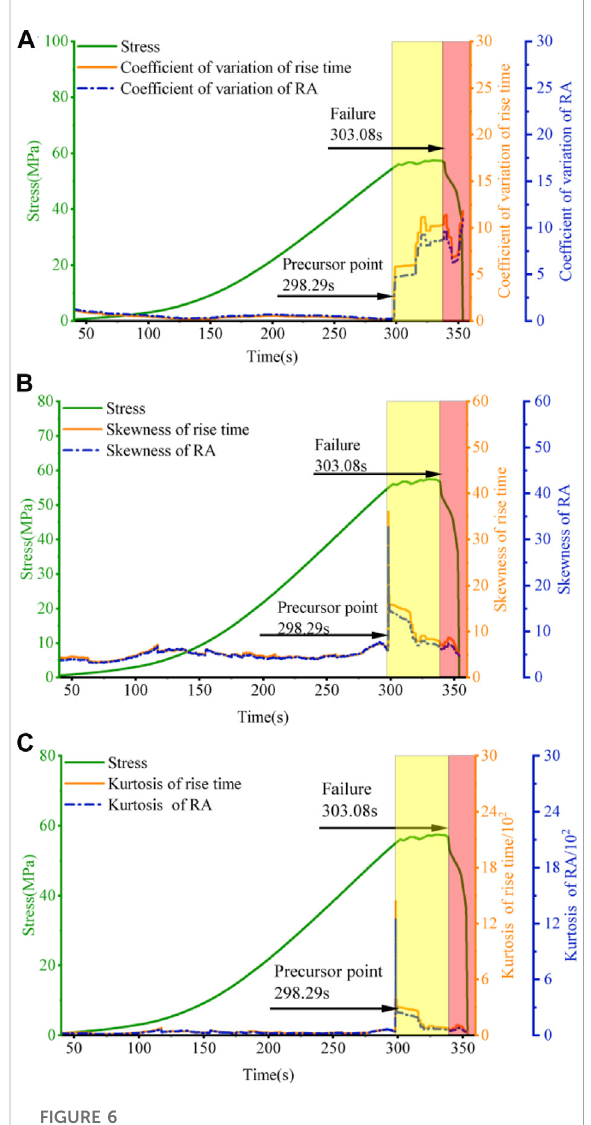
FIGURE 6 TheCSDindicatorofacousticemissionofrocksamplew1. (A) variation coef fi cient characteristics of RA and rise time, (B) skewness characteristics of RA and rise time, and (C) kurtosis characteristics of RA and rise time.